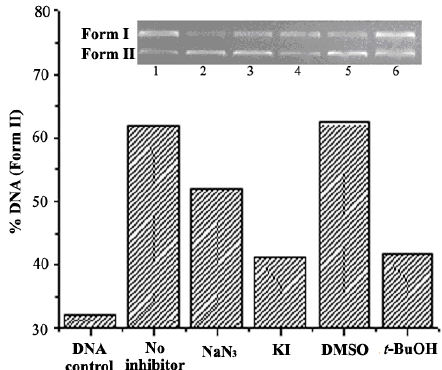
Figure 10. Histograms representing cleavage of pUC19 plasmid DNA (0.008 µg/µL) by compound 2a typical radical scavengers (6.25 × 10 − 7 mol/L, pH = 7.4). Lane 1: DNA control, Lane 2: no inhibitor, Lane 3: NaN 3 , Lane 4: KI, Lane 5: DMSO, Lane 6: t -BuOH.